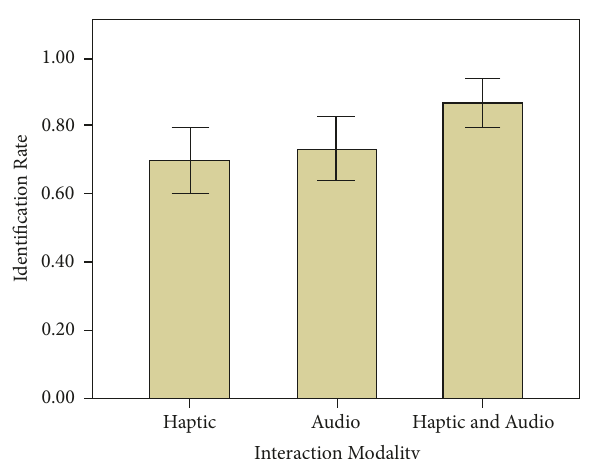
Figure 4: Identification rate with different interaction modalities.